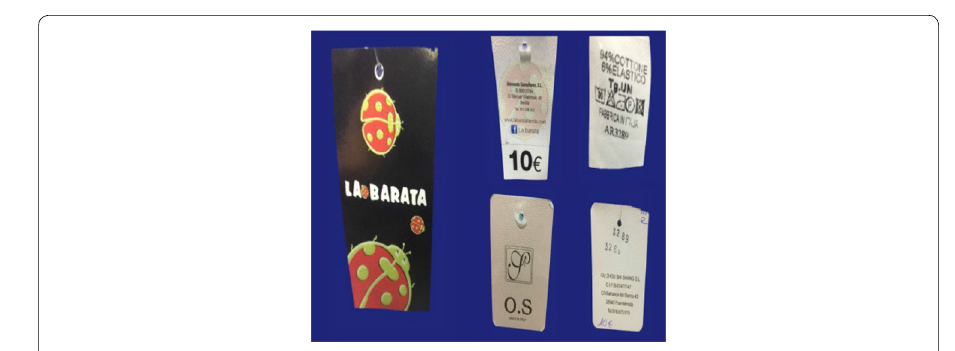
Fig. 26 Kira label